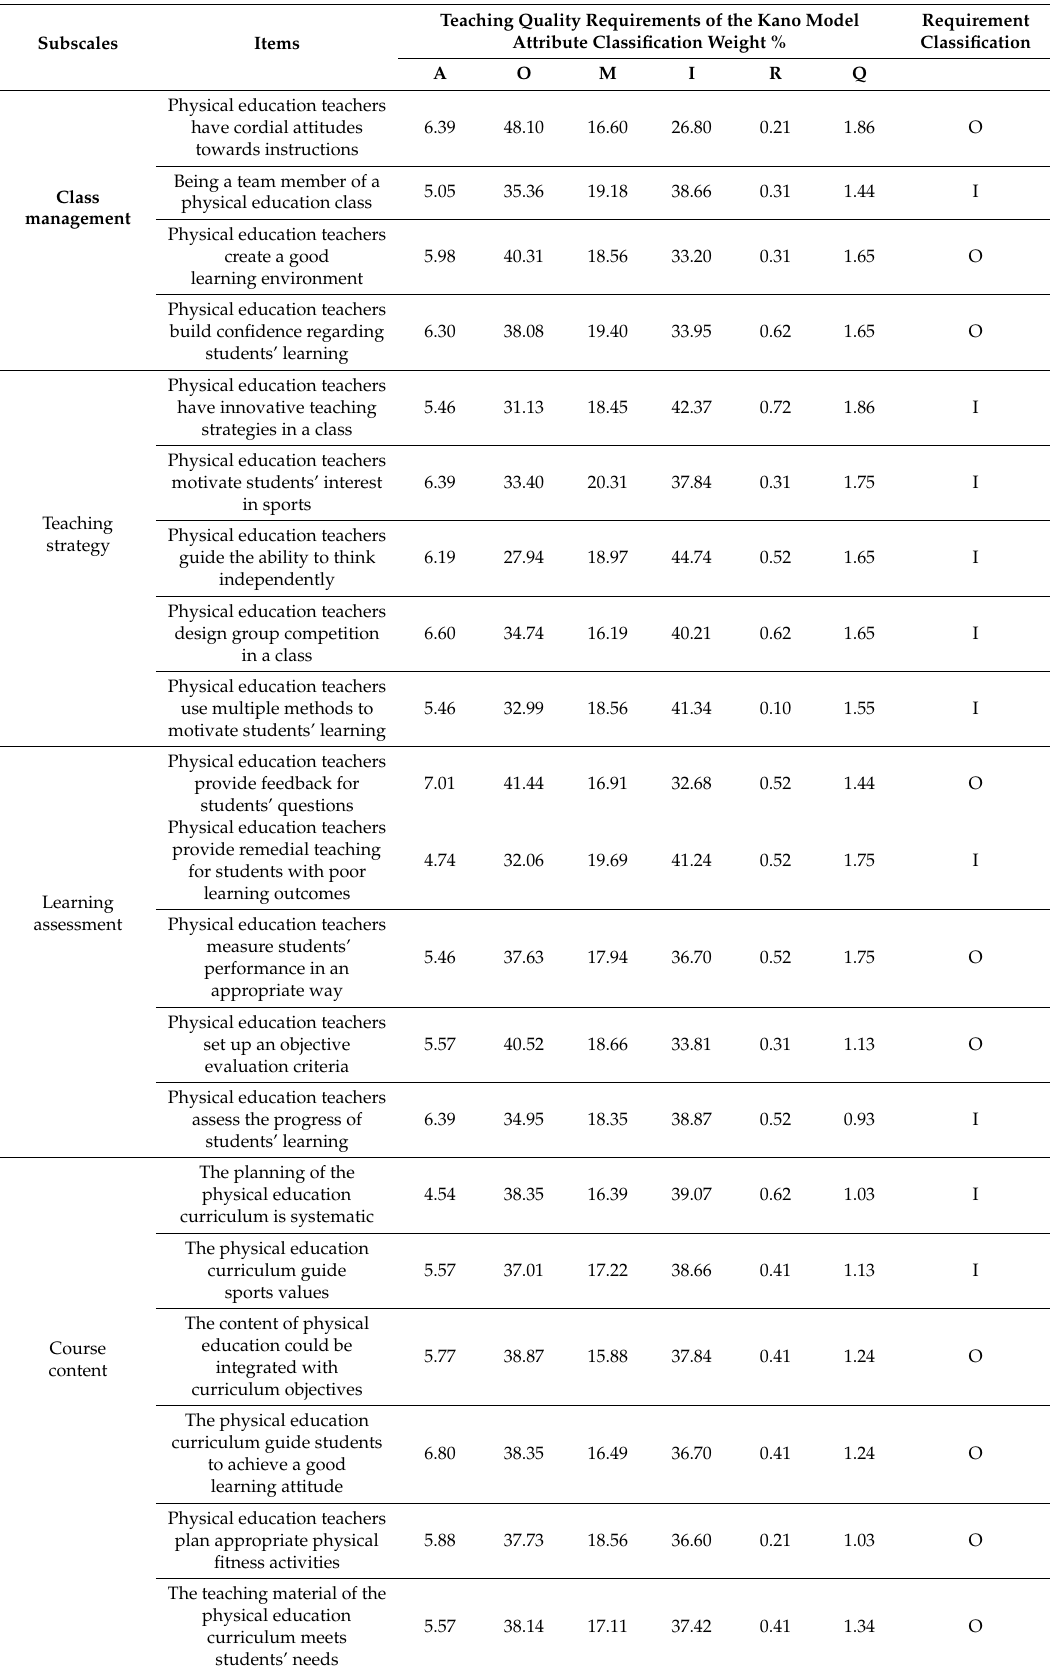
Table 1. Attribute classification of teaching quality of physical education on the Kano model.